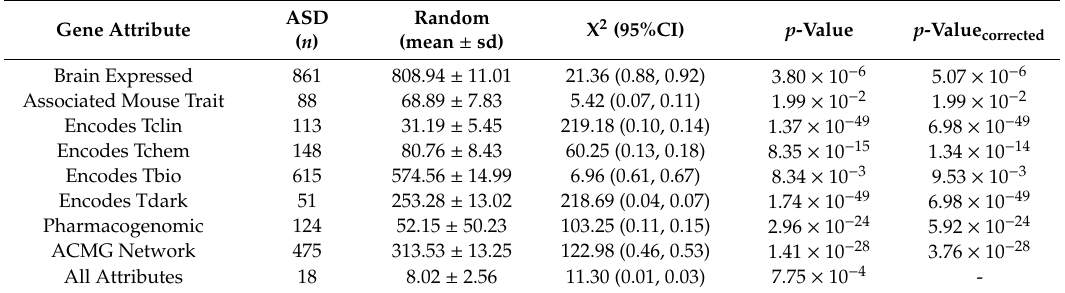
Table 1. Comparisons of Functional Annotations for Autism Spectrum Disorder Candidate Genes to Random